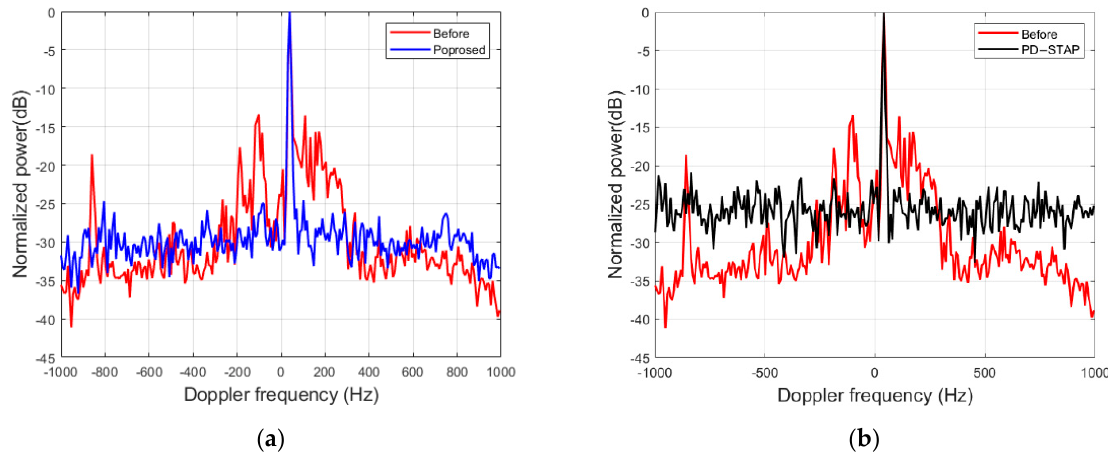
Figure 9. Output normalized SCNR of T1: ( a ) the proposed method; ( b ) PD − STAP.